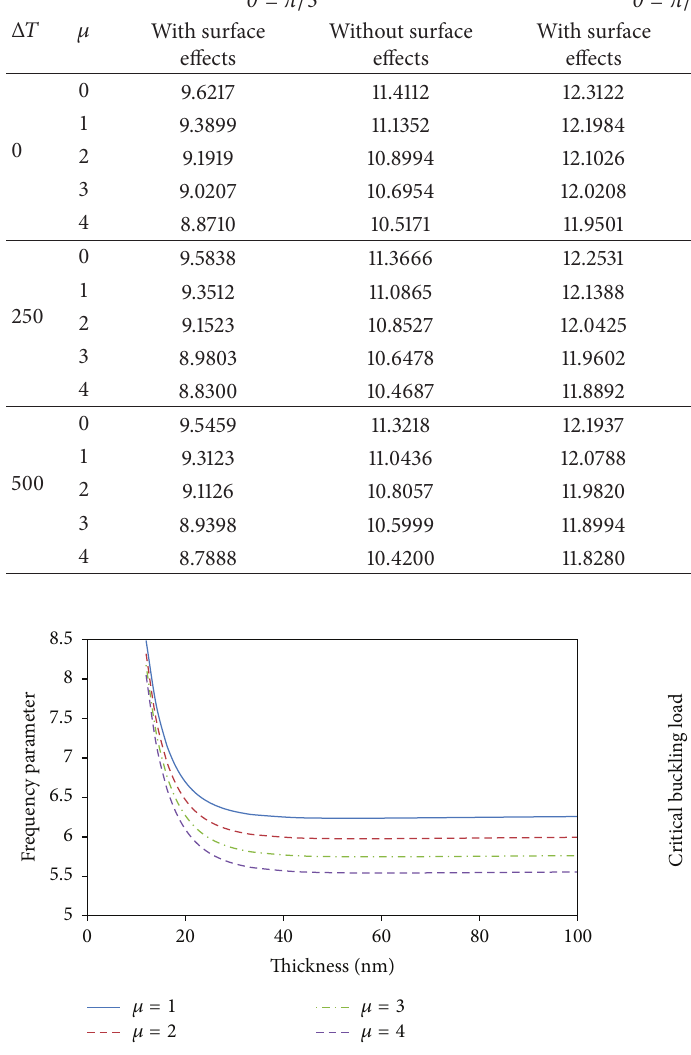
Figure 7: Dimensionless critical buckling load with respect to thickness ℎ for various nonlocalities (𝐾 𝑤 = 10 10 , 𝐾 𝑝 = 10 −6 , 𝑅 = 30 nm , Δ𝑇 = 100)